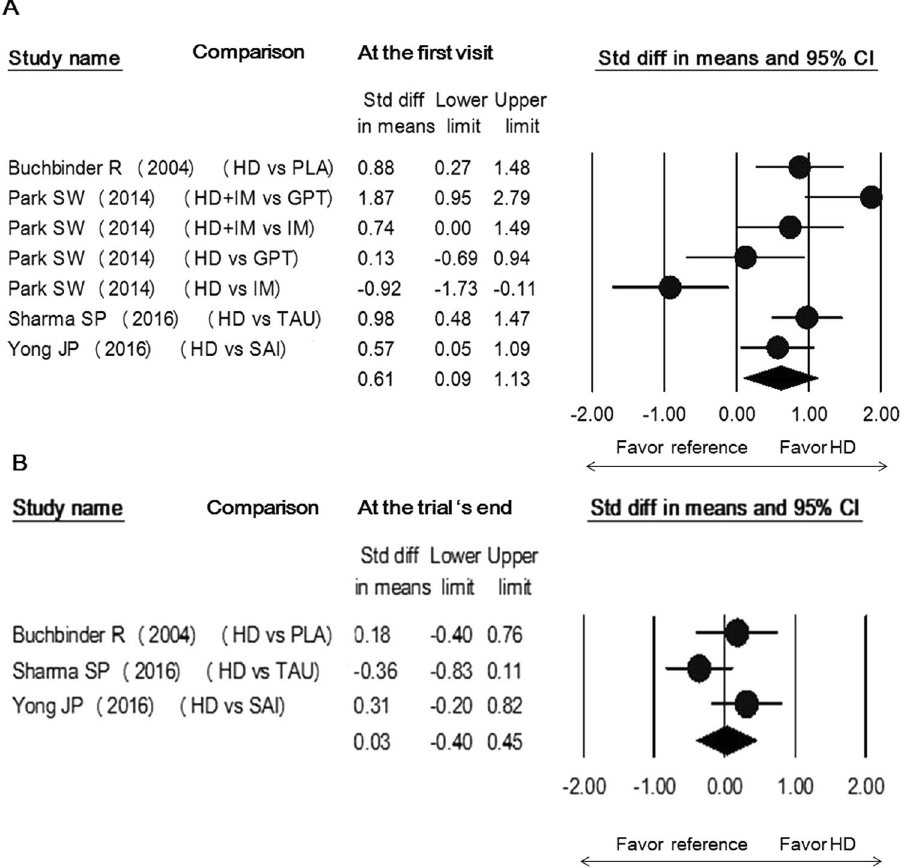
Figure 5. Forest plot of standardized mean differences of improvements in shoulder function comparing the use of hydrodilatation and various reference treatments early following intervention ( A ) and at the trial’s end ( B ). Abbreviations: hydrodilatation, HD; Placebo, PLA; IM, intensive manipulation; GPT, general physical therapy; TAU, treatment as usual; SAI, subacromial